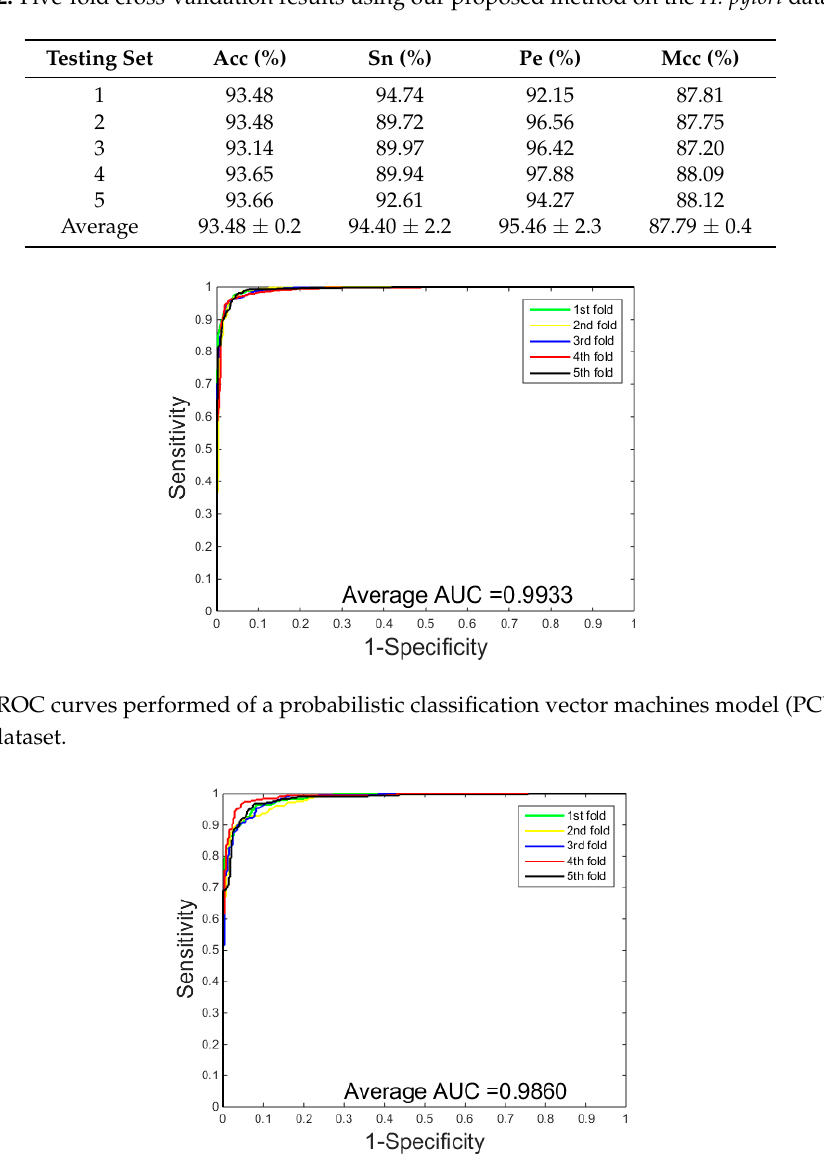
Figure 3. ROC curves performed of PCVM model on the H. pylori dataset.